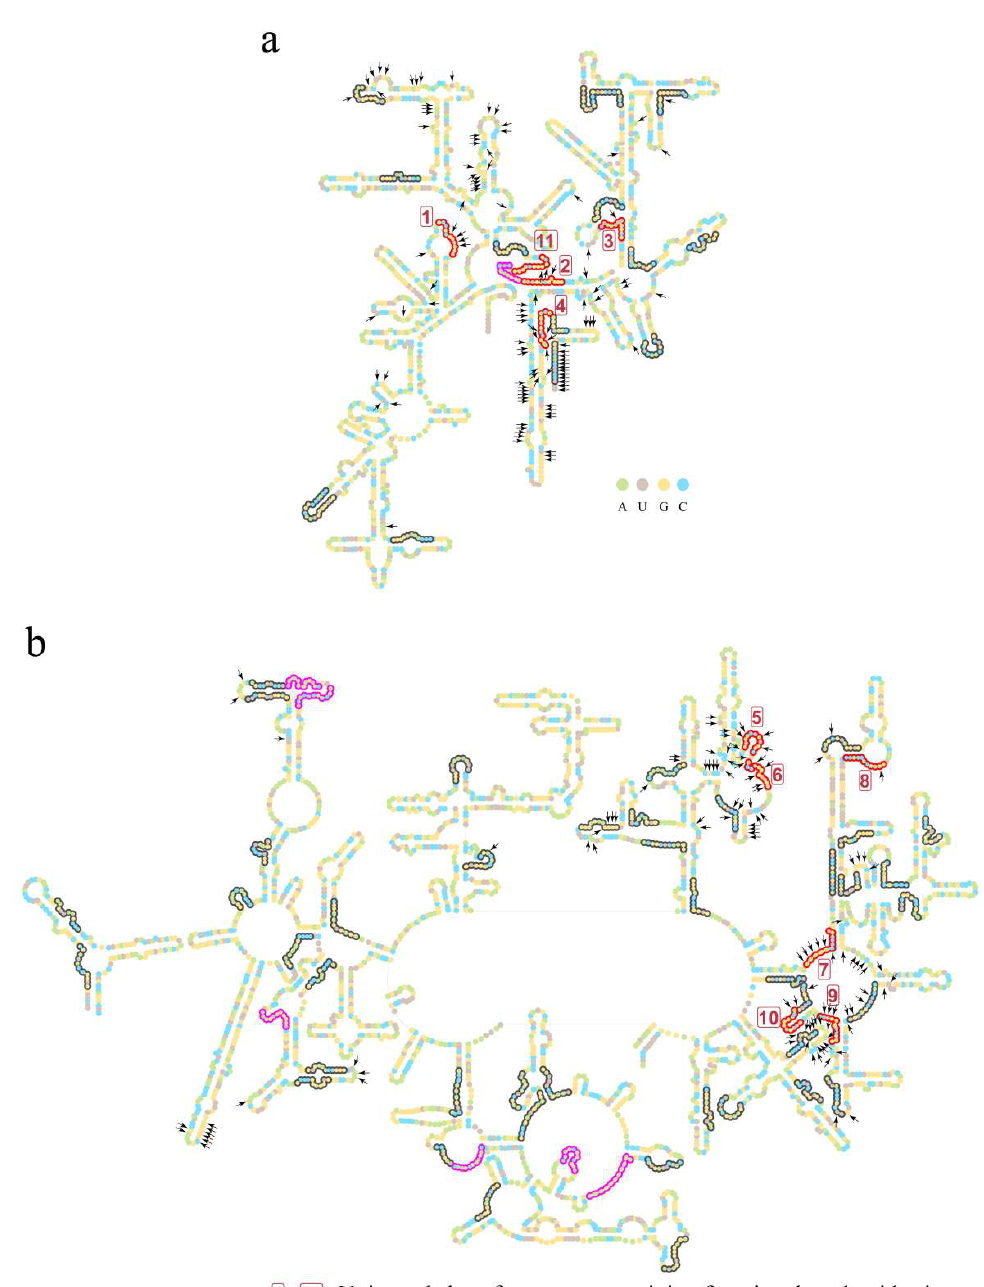
Figure 4. Short fragments with 11 nucleotides in the RY level on secondary structures of LUCA rRNAs. ( a ) Secondary structure of 16S rRNA of LUCA. ( b ) Secondary structures of 5S rRNA (left) and 23S rRNA (right) of LUCA. Bases are indicated by colored circles. The black arrows mark the 226 nucleotides that were orthologous to the nucleotides performing functions in the ribosome (in total, 230 functional nucleotides were summarized, while 4 nucleotides’ orthologous sites were gaps in the reconstructed LUCA rRNA chains. Thus, a total of 226 nucleotides was marked). Short fragments are outlined by colored curves. Red and magenta curves outline the 18 universal short fragments, which were conserved across at least 5 of archaea, bacteria, protists, fungi, plants, and animals. Red curves and boxed numbers (from 1 to 11) outline and mark the 11 universal short fragments whose orthologous sequences of E. coli contain nucleotides performing functions in the ribosome. Magenta curves outline the other 7 universal short fragments containing no functional sites. An additional 57 short fragments are outlined by gray curves.